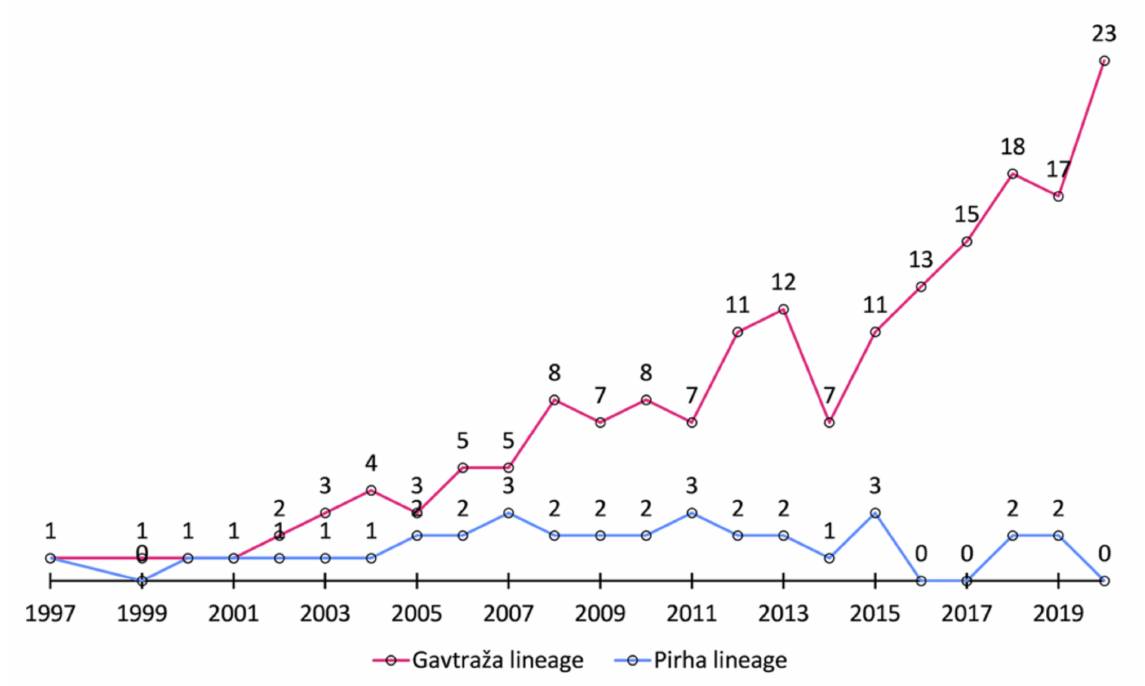
Figure 1. The number of animals born from 1997 to 2000 in the “mutant”